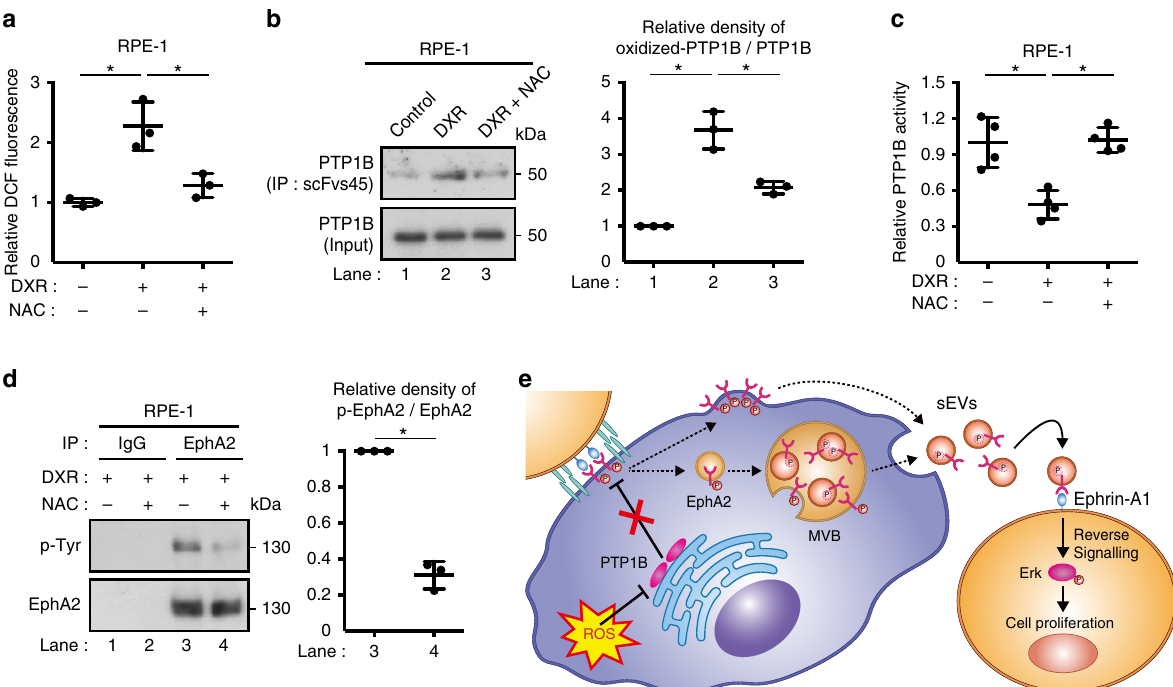
Figure 8 | Increased ROS induce EphA2 phosphorylation via PTP1B inactivation. ( a ) Intracellular ROS levels were measured by DCF fluorescence in RPE-1 cells treated with or without DXR and NAC. NAC was added to the medium 6h before analysis at a concentration of 2mM. ( b ) Oxidized-PTP1B was immunoprecipitated by scFvs45 antibody from RPE-1 cells treated with or without DXR and NAC. Inputs and immunoprecipitates were immunoblotted with anti-PTP1B antibody. Dot plot represents the relative density of oxidized-PTP1B/PTP1B analysed by ImageJ. ( c ) Relative PTP1B activity in RPE-1 cells treated with or without DXR and NAC. ( d ) EphA2 immunoprecipitates prepared from RPE-1 cells treated with or without DXR and NAC were immunoblotted with anti-phosphotyrosine and anti-EphA2 antibody. Dot plot represents the relative density of phospho-EphA2/EphA2 analysed by ImageJ. ( e ) Schematic model of the regulation and function of sEV-associated EphA2 in senescent cells. Replicates are biological replicates ( n ¼ 3 for a , b , d and n ¼ 4 for c ). Error bars indicate s.d. * P o 0.05 (one-way ANOVA with the post-hoc Dunnett’s two-tailed test for a – c ) and two-tailed t -test for d ferrocyanide, 2mM MgCl 2 , 150mM NaCl, 1mgml (cid:3) 1 X-Gal) in citrate/sodium phosphate buffer (pH 6) overnight at 37 (cid:2) C. Cells were then washed twice with PBS, and the percentage of stained cells was determined.